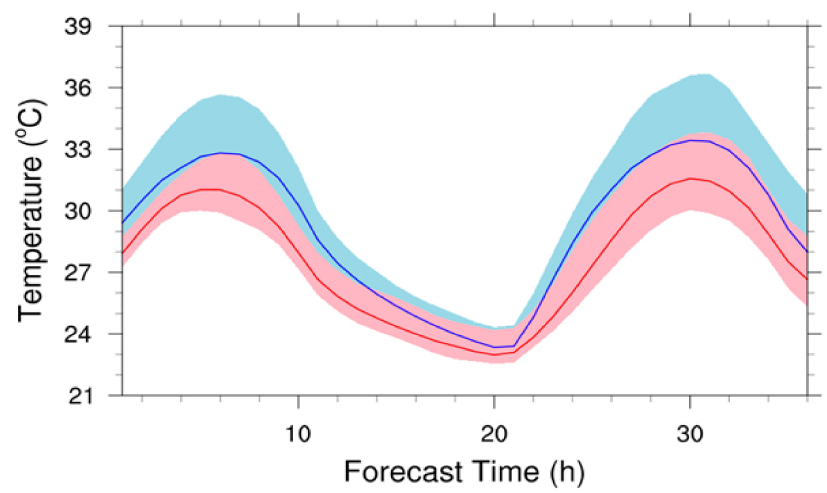
Figure 2. Time series of 1.5-m temperature averaged for 56 AWS sites (black dashed line) and CTL run (red solid line). The shaded area is the 7-day maximum and minimum of each forecast time.